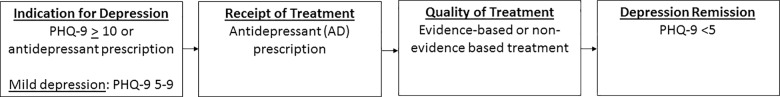
The depression treatment cascade for HIV-infected adults.